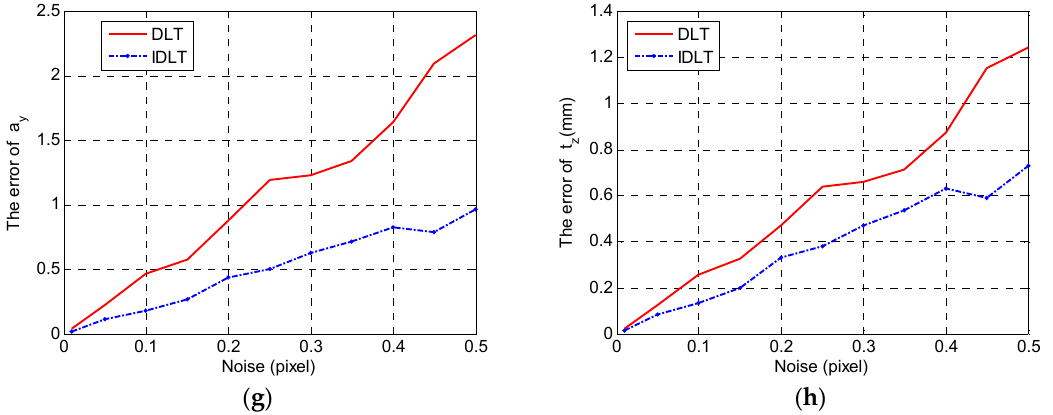
Figure 6. Calibration error analysis between direct linear translation (DLT) and improved DLT (IDLT) with noise: ( a ) error of u 0 ; ( b ) error of v 0 ; ( c ) error of t x ; ( d ) error of t y ; ( e ) error of a x ; ( f ) error of t z based on a x ; ( g ) error of a y ; ( h ) error of t z based on a y .